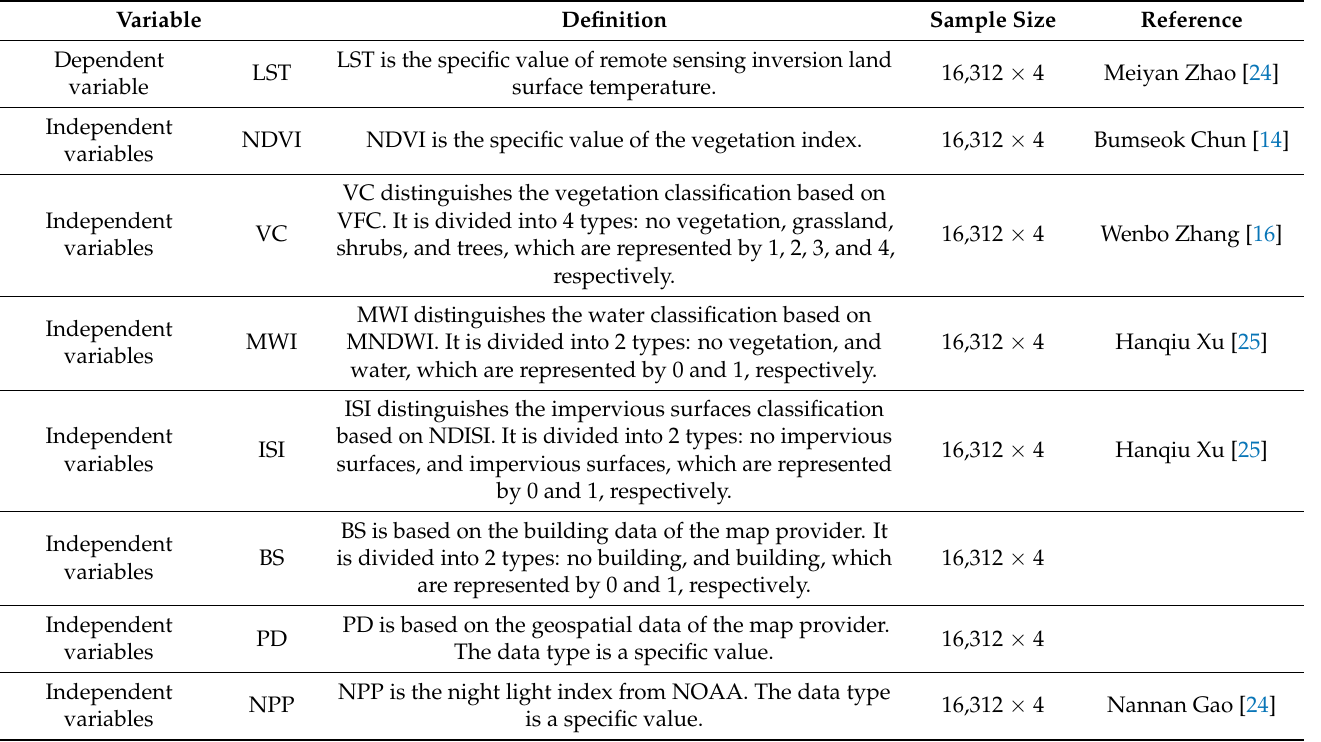
Table 1. Variables in the